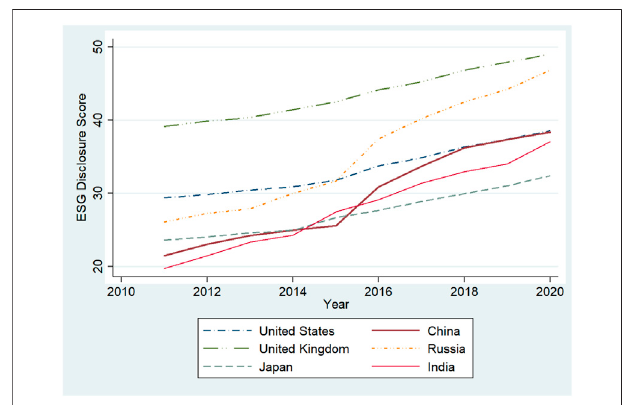
FIGURE 1 | ESG disclosure score by